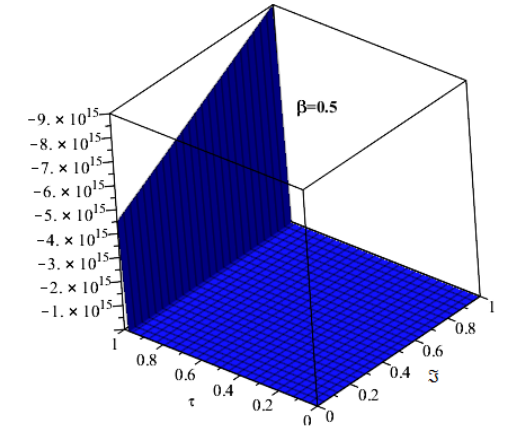
Figure 18. The solution of fractional-order β = 0.5 of Example